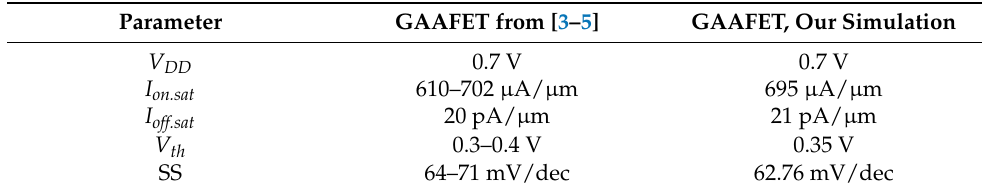
Table 2. Electrical properties used in the